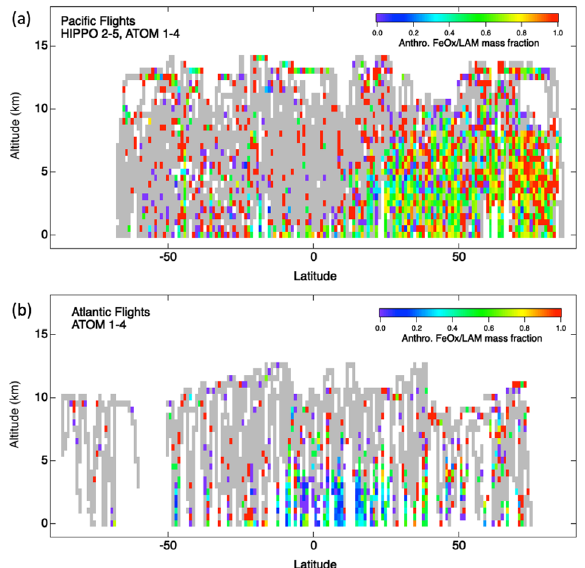
Fig. 3 Relative anthropogenic-like FeO x to total LAM aerosol mass over remote Paci fi c and Atlantic. Each bin represents a 0.5 km by 1.0° latitude over the Paci fi c (Panel a ) and Atlantic (Panel b ). Observations are only shown in cloud-free regions where LAM aerosols were detected by the